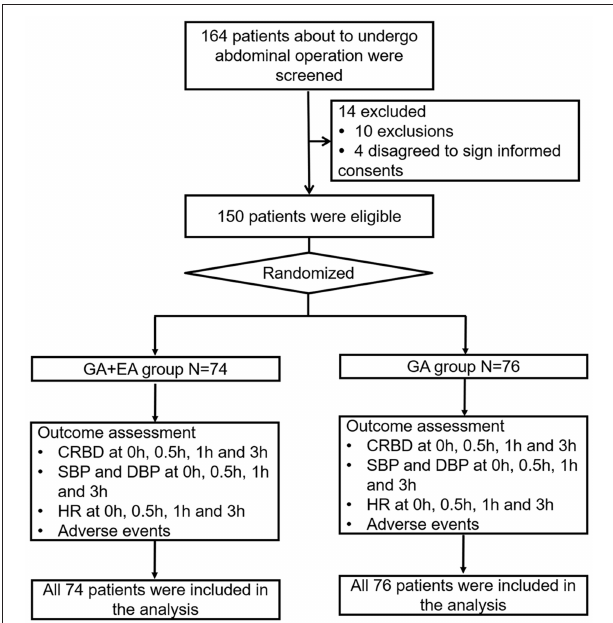
FIGURE 1 | Flow chart. GA, general anesthesia; EA, epidural anesthesia; CRBD, catheter-related bladder discomfort; SBP, systolic blood pressure; DBP, diastolic blood pressure; HR, heart rate.